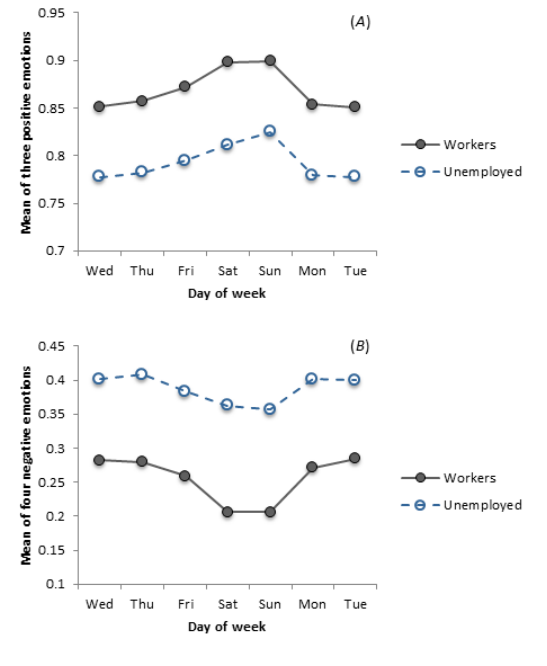
Figure 2: ( A ) Positive and ( B ) negative emotions by day of week. From Gallup Daily Poll, 2009–11. day of the week (less happiness, more stress and worry) compared to workers. This is consistent with previous work on the experience of unem- ployment (e.g., Young 2012; Burgard, Brand, and House 2007). Third, the weekend effects for workers are strikingly similar to those of the un- employed. Though the unemployed do not go to work, they seem to be looking forward to the weekend in much the same way as workers.